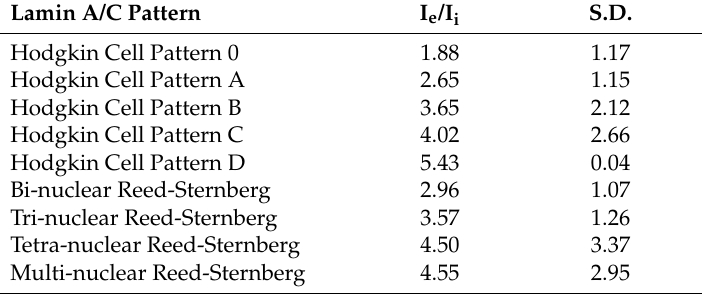
Table 2. Quantitative analysis of lamin A/C patterns in H and RS cells. 30 H and 30 RS cells of the cHL-derived cell line HDLM-2 from three independent experiments were analyzed. Total external lamin A/C signal intensity (I e ) was divided by the total internal lamin A/C signal intensity (I i ) to obtain a ratio. Resulting ratios and S.D. are